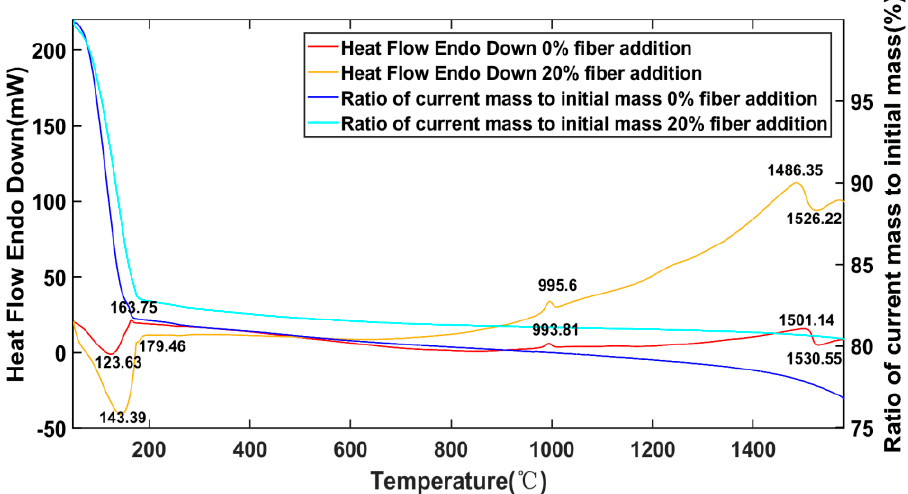
Figure 7. Infrared spectra of geopolymers treated with different fiber ratios and temperatures. ( a ) FTIR spectrums of 0% fibre and 20% fibre without heat treatment; ( b ) FTIR spectrums of 0% fibre with heat treatment at various temperature.